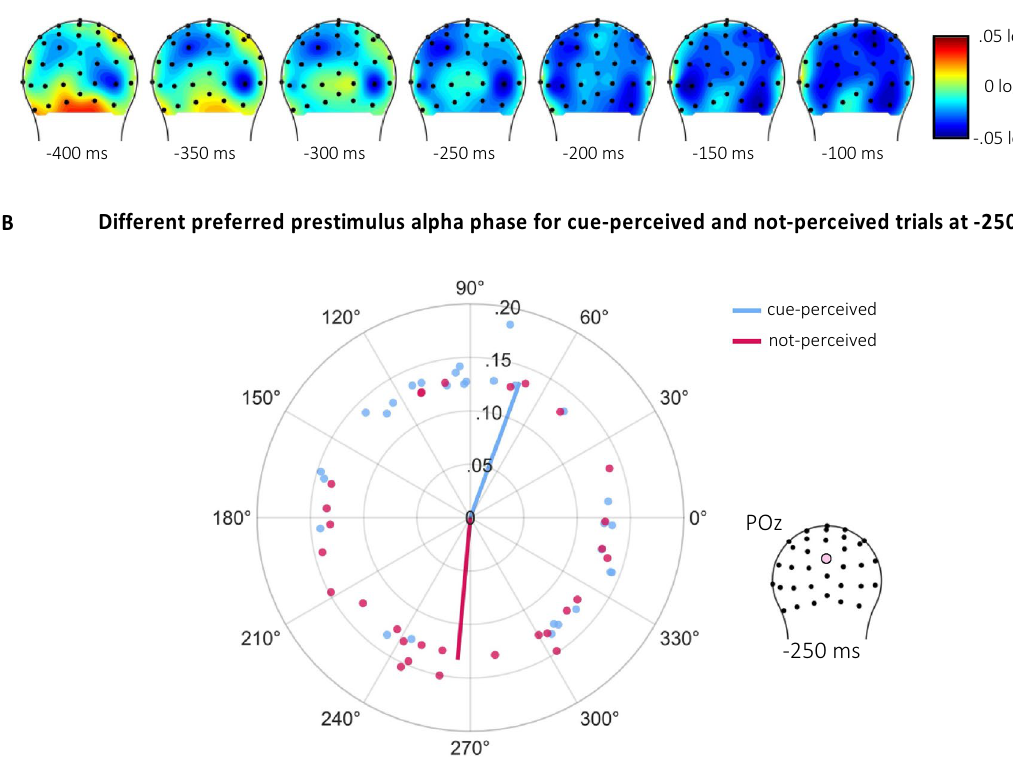
Figure 2. ( A ) The topographic distribution of prestimulus alpha power (8–12 Hz) for cue-perceived minus not-perceived trials. To test this difference, power was averaged at -250 ms pre-cue across 8–12 Hz and across an occipitoparietal region of interest (ROI). However, a Bayesian generalized mixed-effect regression analysis showed no statistical evidence that prestimulus alpha power differed between cue-perceived and not-perceived trials. ( B ) The average preferred prestimulus alpha phase for cue-perceived (blue lines) and not-perceived trials (red lines). A Bayesian generalized mixed-effect regression analysis showed moderate evidence that these preferred prestimulus alpha phases were different between these conditions. The vector length represents intertrial phase coherency (ITPC). Data points reflect the preferred phase and ITPC for individual subjects. Phase measures of the prestimulus alpha activity were extracted from a window centered at -250 ms (relative to cue stimulus onset) at electrode site